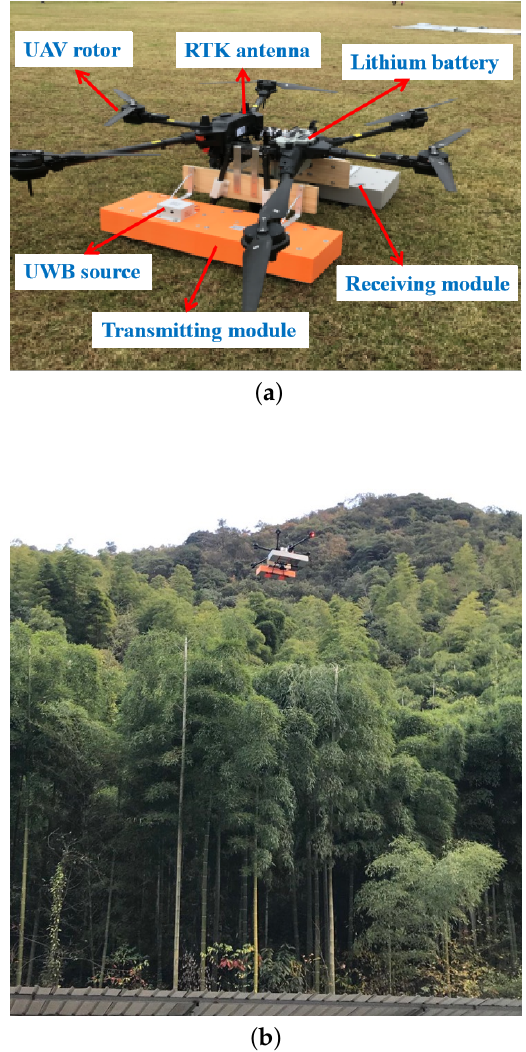
Figure 1. The real picture of UAV-GPR System. ( a ) The architecture of the system, including four modules: UAV platform, radar transceiver module, data acquisition module, and signal processing module. ( b ) The UAV-GPR system is in flight above the